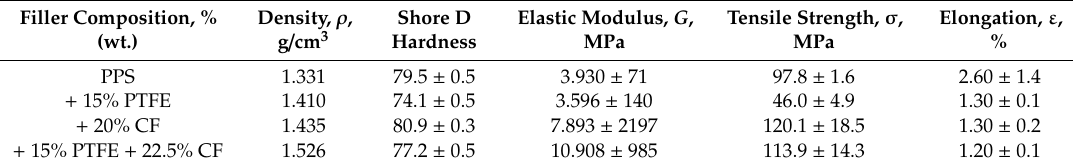
Table 5. Mechanical properties of PPS, as well as the PPS-based two- and three-component composites. Filler Composition, % (wt.)